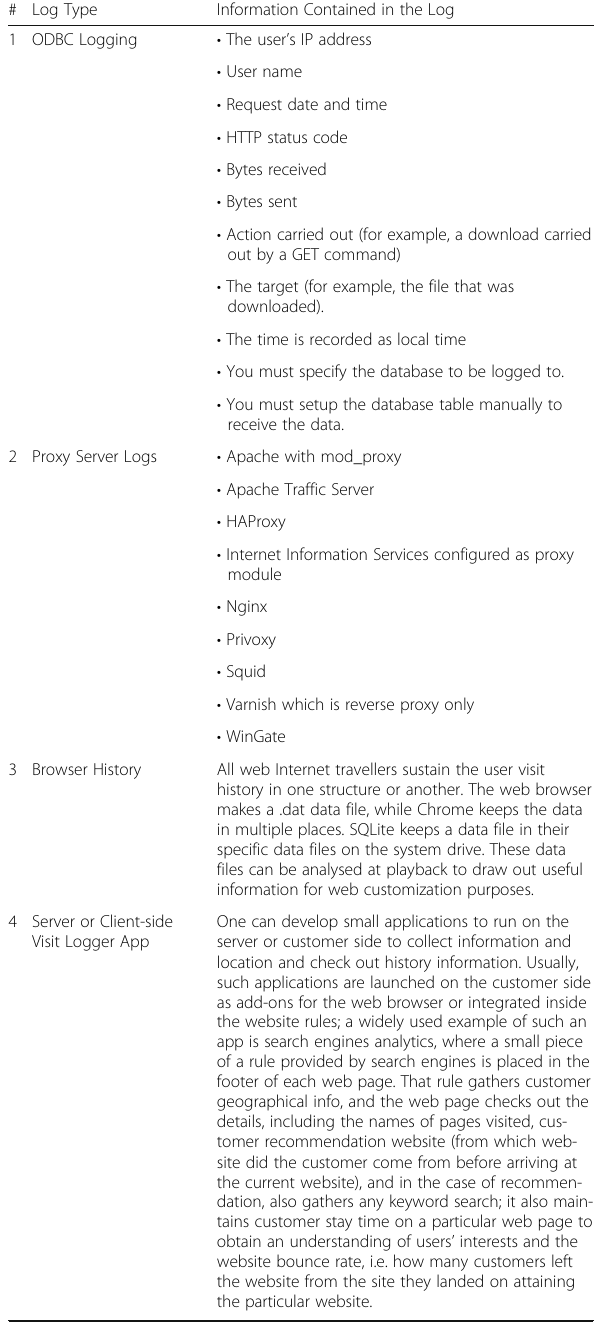
Table 2 Machine and Network Data sources # Log